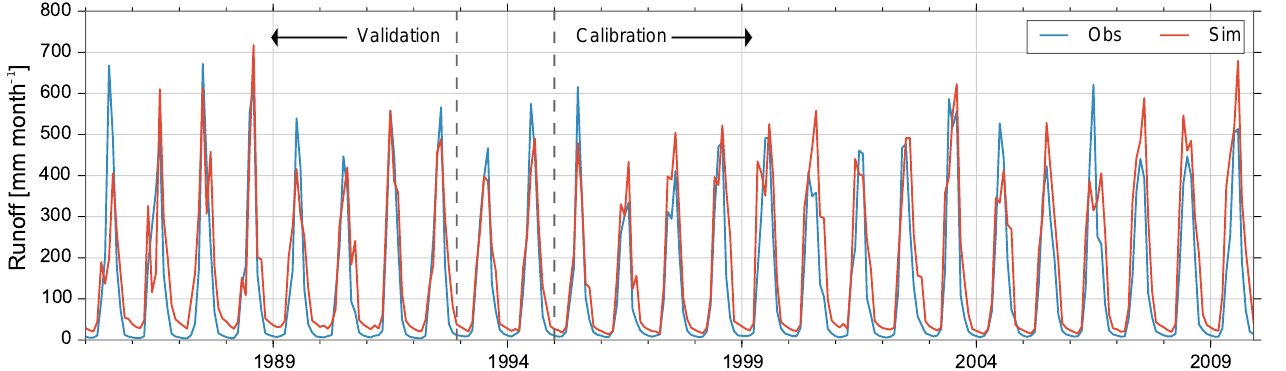
Figure 4. Time series of observed (blue line) and modelled runoff (red line) calculated using the water balance model AWARE forced by CFSv2 data.